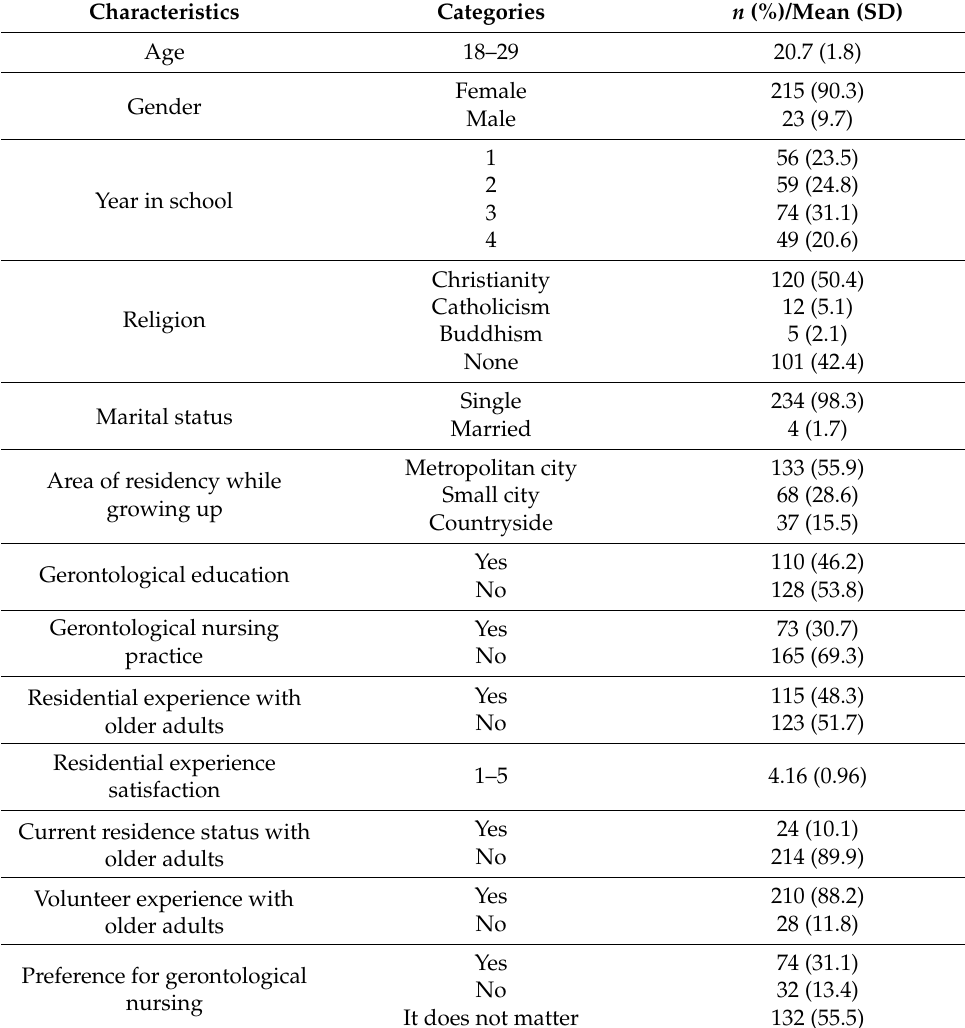
Table 1. Sociodemographic and geriatric-related characteristics of participants ( N = 238). Characteristics